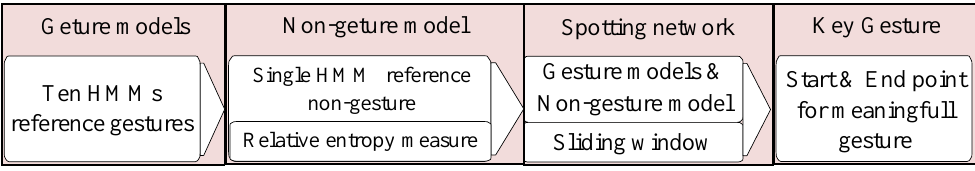
Figure 5. Key gesture spotting roadmap using HMMs.